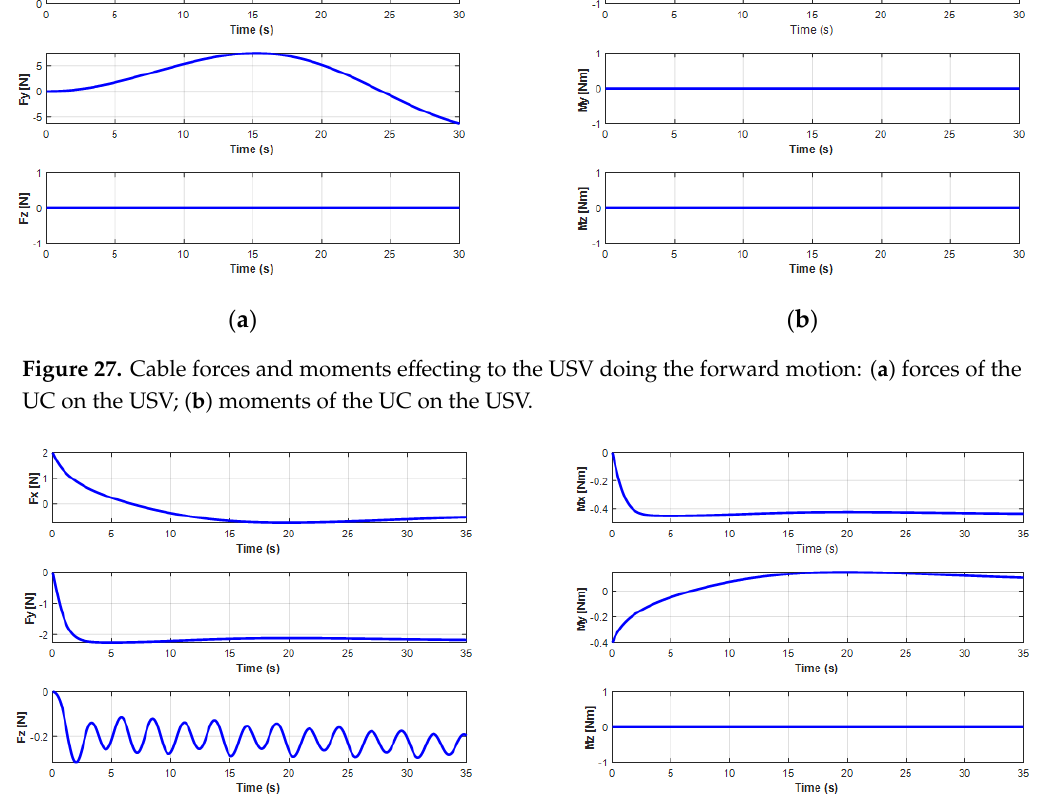
( b ) Figure 29. Simulation results of position and velocity of the USV doing the forward motion: ( a ) position of the USV; ( b ) velocity of the USV. ( a ) ( b ) Figure 30. Simulation results of position and orientation of the UUV doing the sideward motion: ( a ) position of the UUV; ( b ) orientation of the UUV.